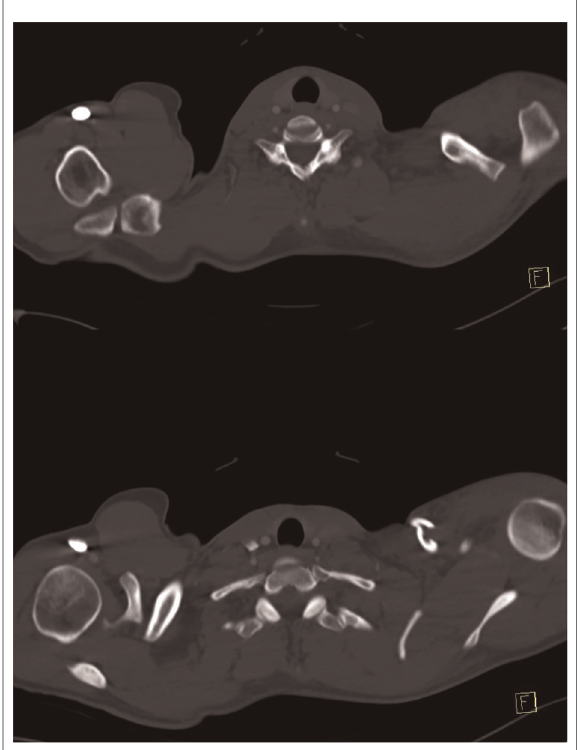
FIGURE 3 Axial computed tomography demonstrating concomitant midshaft clavicle fracture and Rockwood Type V acromioclavicular joint dislocation.